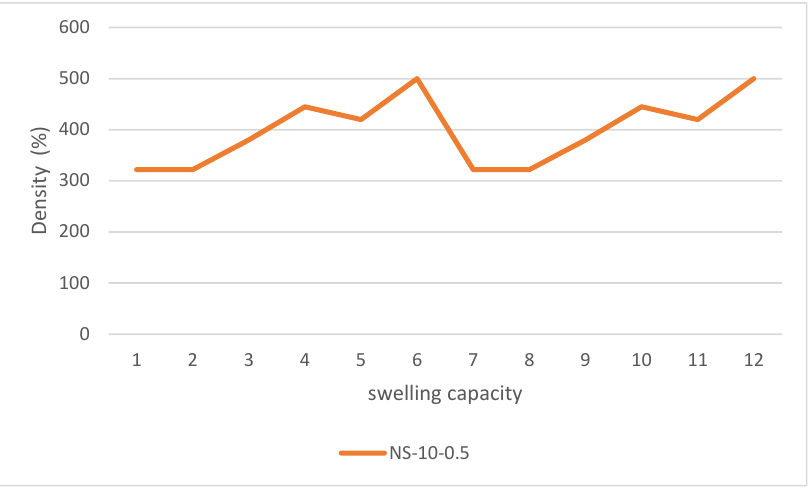
Figure 12. Observed 80% increase in equilibrium swelling capacity of NS-10-0.5 compared with NS-10-2.